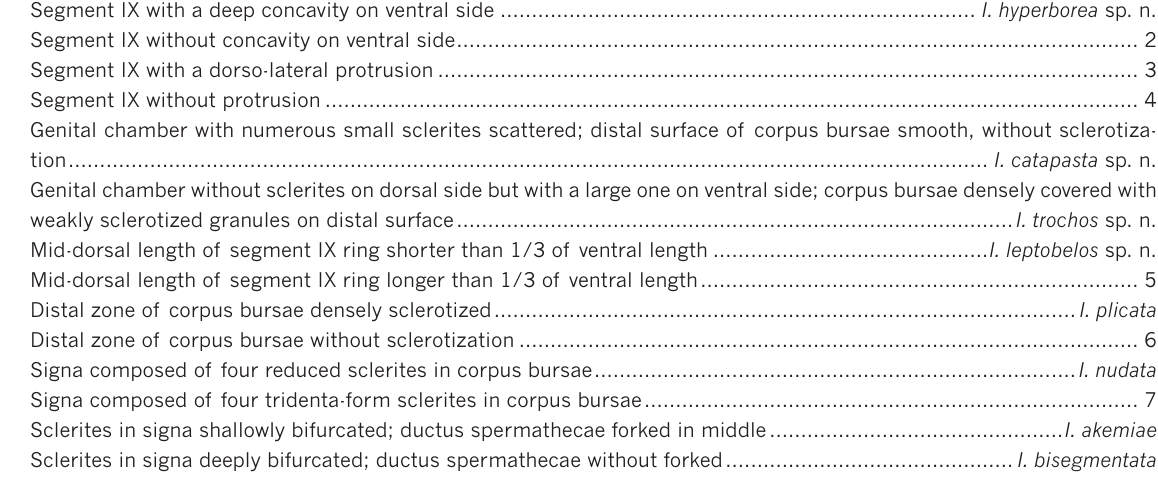
(Fig. 19:21); 2♂ emerged on 19.VI.2015 collected as lar- vae by YI on 17.V.2015 at same locality; 3♂ collected by YI on 27.VI.2015 at Goreibitsu-touge, Konan-cho, Fukushima Pref (Fig. 19:22); 1♂ collected on